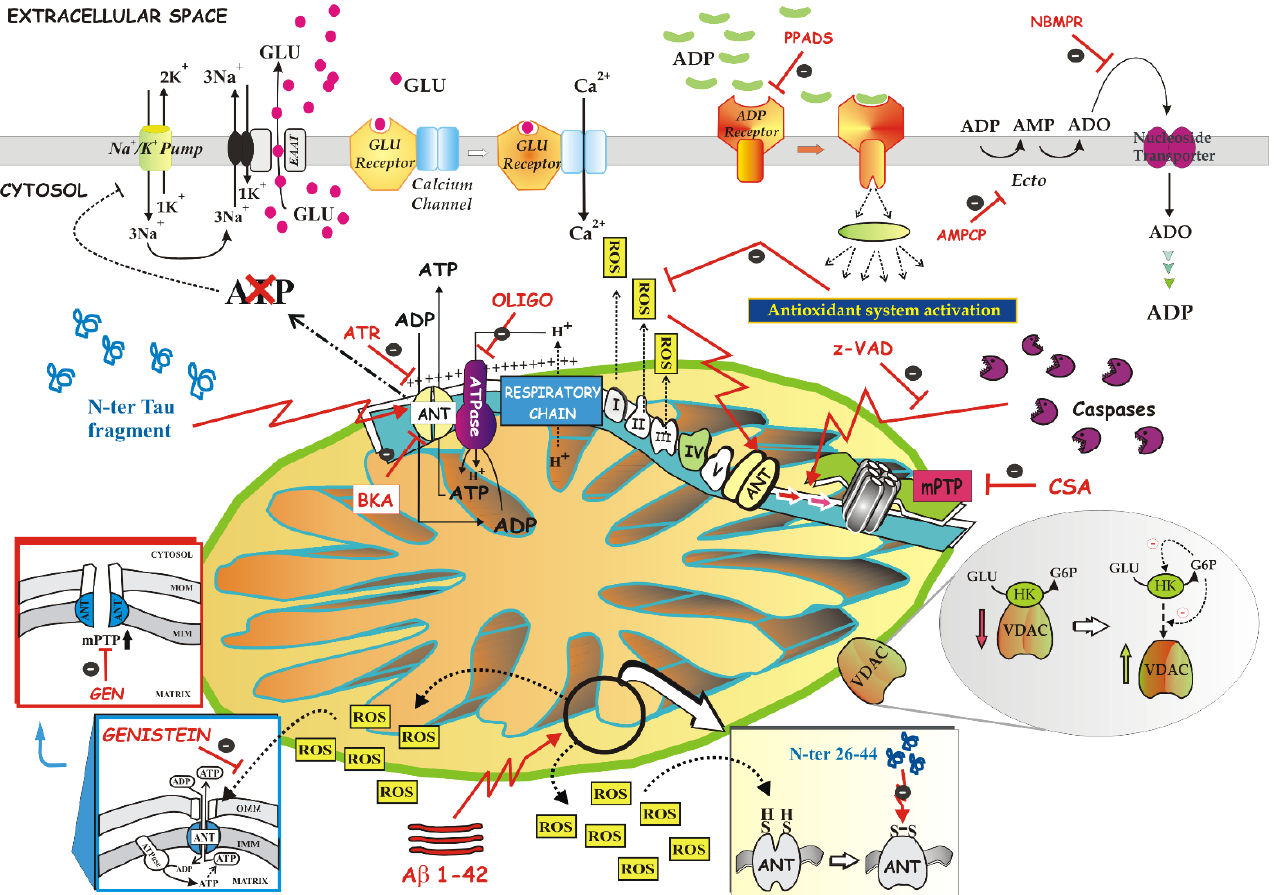
Figure 3. The picture collects data from several studies on the role of ANT and its functionality in the neurons sentenced to death for apoptosis or necrosis. In particular, the dual role of ANT, harboring two opposite functions, i.e., a vital function important to ensuring the life of the cell, and the other lethal—such as protein involved in the participation of mPTP opening—leading the cell to death, is depicted. The effect of NH 2 htau and A β 1-42 peptides impairing mitochondrial ANT-1 in Alzheimer’s disease is also shown. The data represented here refer to the reference numbers [145–153].